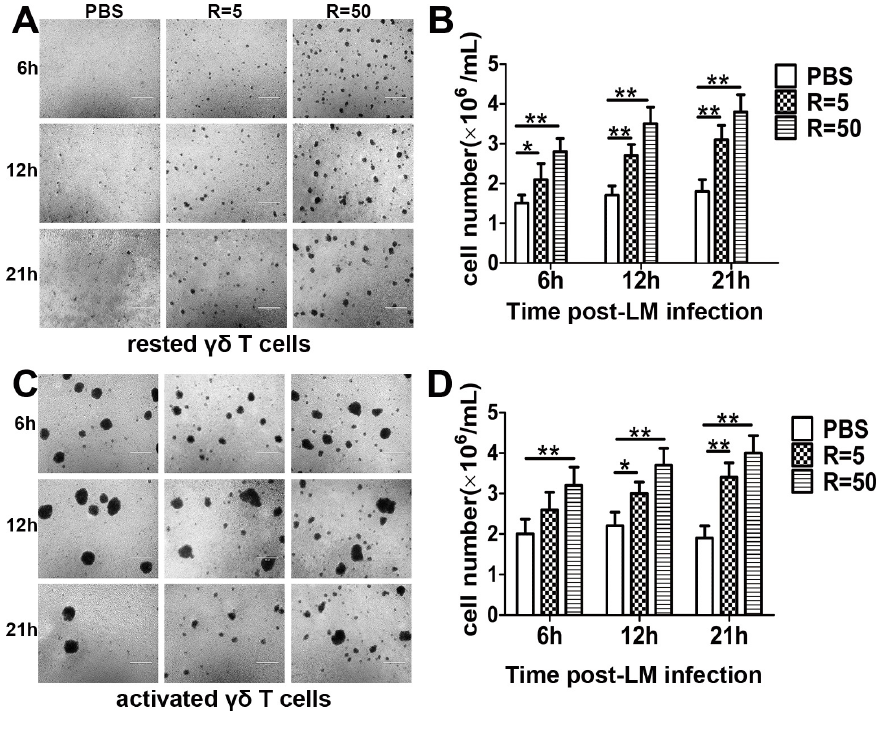
Figure 2. γδ T cells proliferated to form colonies after incubation with L. monocytogenes . (A) Many new and small colonies were observed after rested γδ T cells were incubated with L. monocytogenes . R is the ratio of L. monocytogenes to γδ T cells. PBS was used as control. More bacteria induced more colonies of γδ T cells. (B) Quantification of total cell numbers of rested γδ T cells in different groups. (C) Activated γδ T cells gathered to many large colonies 14 d after culture. After incubation with L. monocytogenes , some small and new colonies appeared. Over 21 h the number of large colonies decreased and small new colonies grew in size and number. Scale bars = 100 μ m. (D) Quantification of total cell numbers of activated γδ T cells in different groups. Data are shown as mean ± SEM.* P < 0.05. ** P < 0.01. (Independent experiments: n =